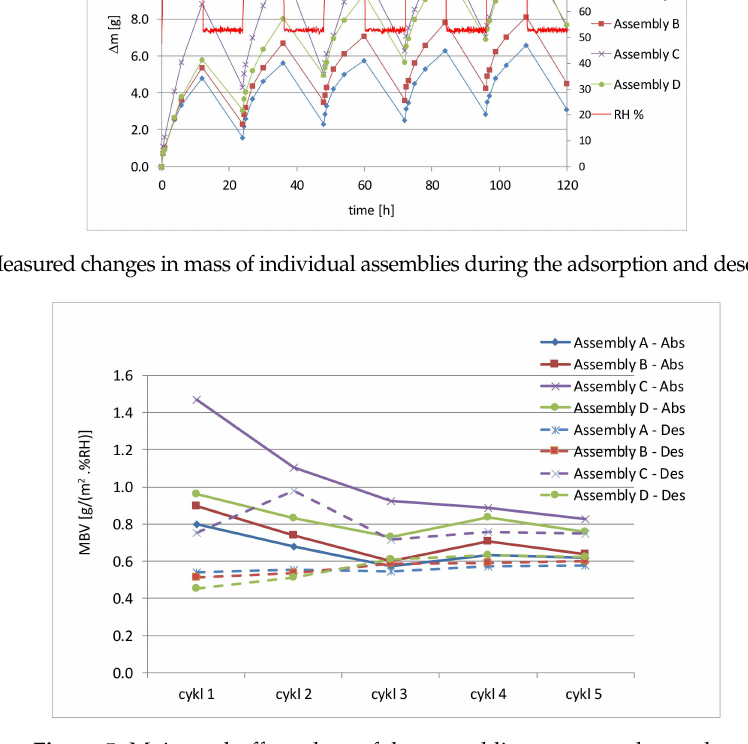
Figure 5. Moisture bu ff er values of the assemblies versus cycle